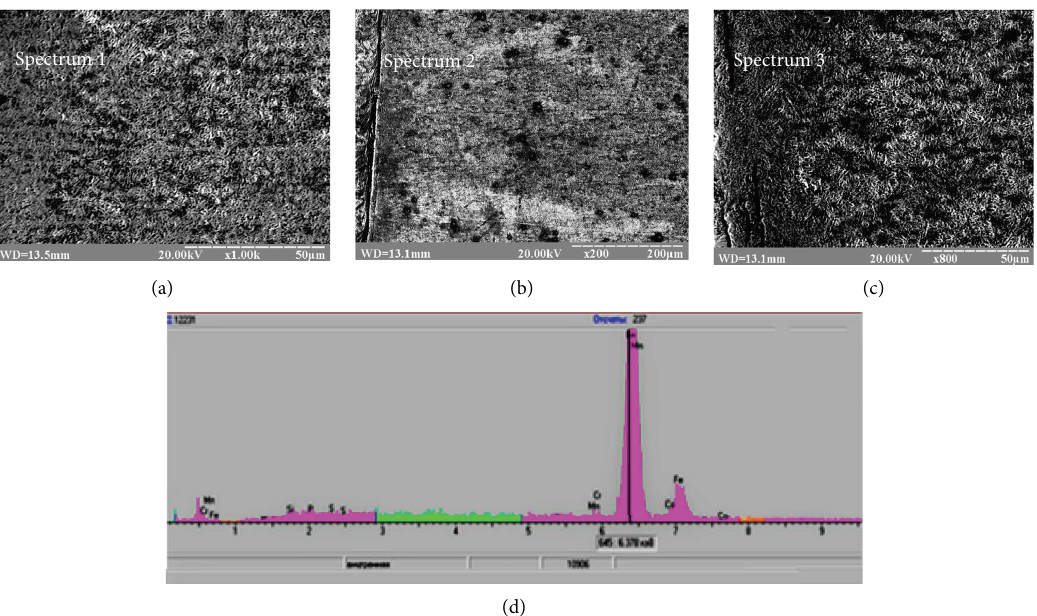
Figure 10: Te scanning electron microscopic image in backscattered electrons of the microstructure of the cross-sections of the 30ChGSA steel samples before (a, d) and after tribological tests during lubrication with sample 1 (b) and sample 2 (c). Te rectangular zones indicate the areas of micro-X-ray spectral analysis of the chemical composition. Table 5: Chemical composition (at %) of the selected microstructural elements of the cross-section of samples of steel 30ChGSA. Element Spectrum